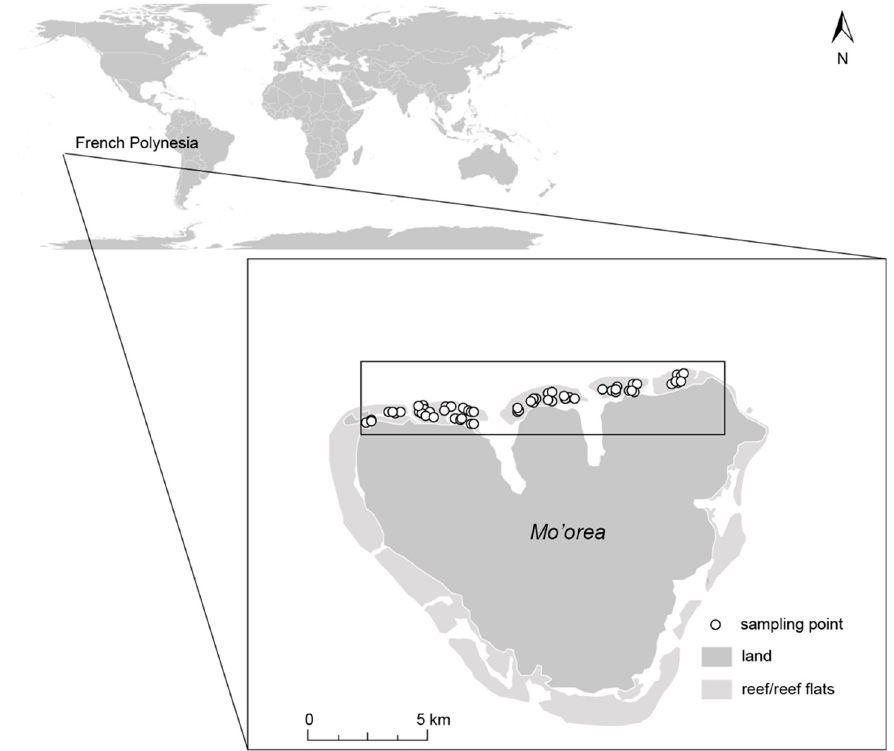
Figure 1. The island of Mo’orea, French Polynesia and its location in the Pacific Ocean. The north shore, where all survey points were located, is indicated with a black square.